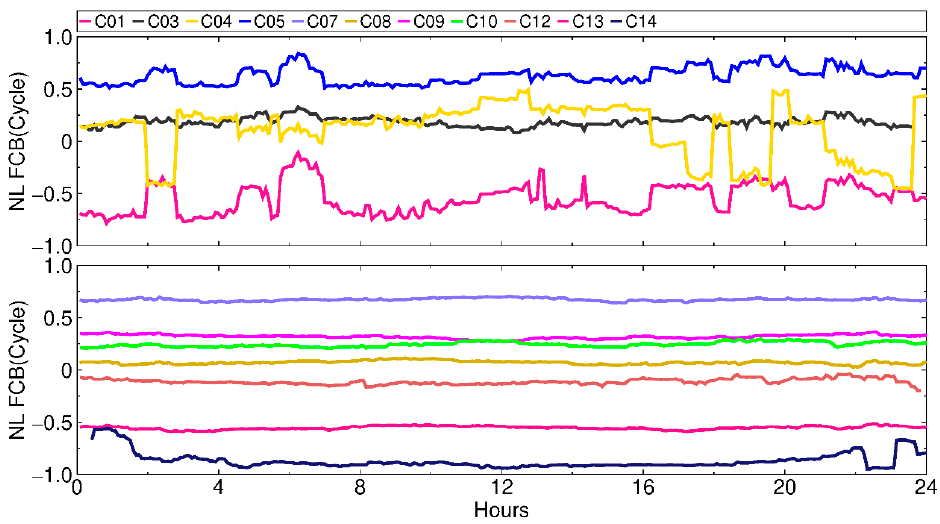
Figure 7. BDS NL FCB on DOY 328, 2018. Top panel: BDS GEO. Bottom panel: BDS non-GEO. C02 and C06 are taken as the reference for BDS GEO and non-GEO respectively.